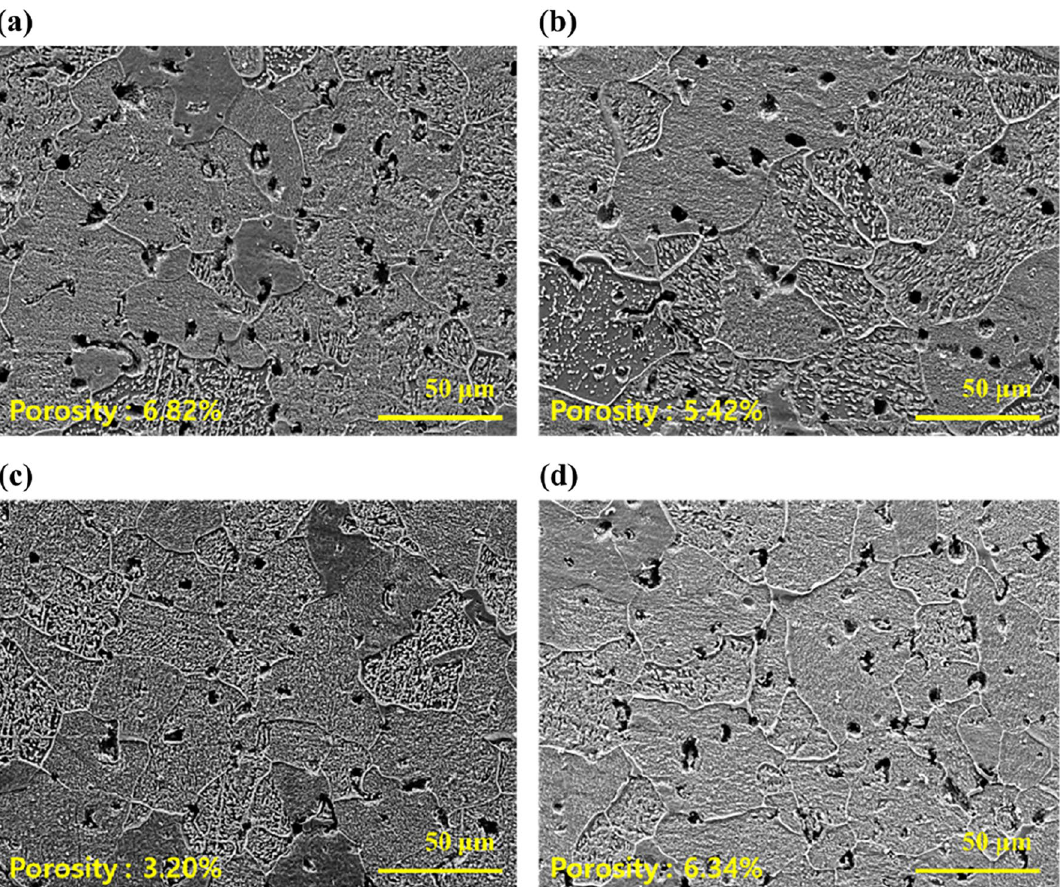
Figure 10. SEM images of sintered Fe trimodal feedstocks with ( a ) 60 vol.%, ( b ) 65 vol.%, ( c ) 70 vol.% and ( d ) 75 vol.%.